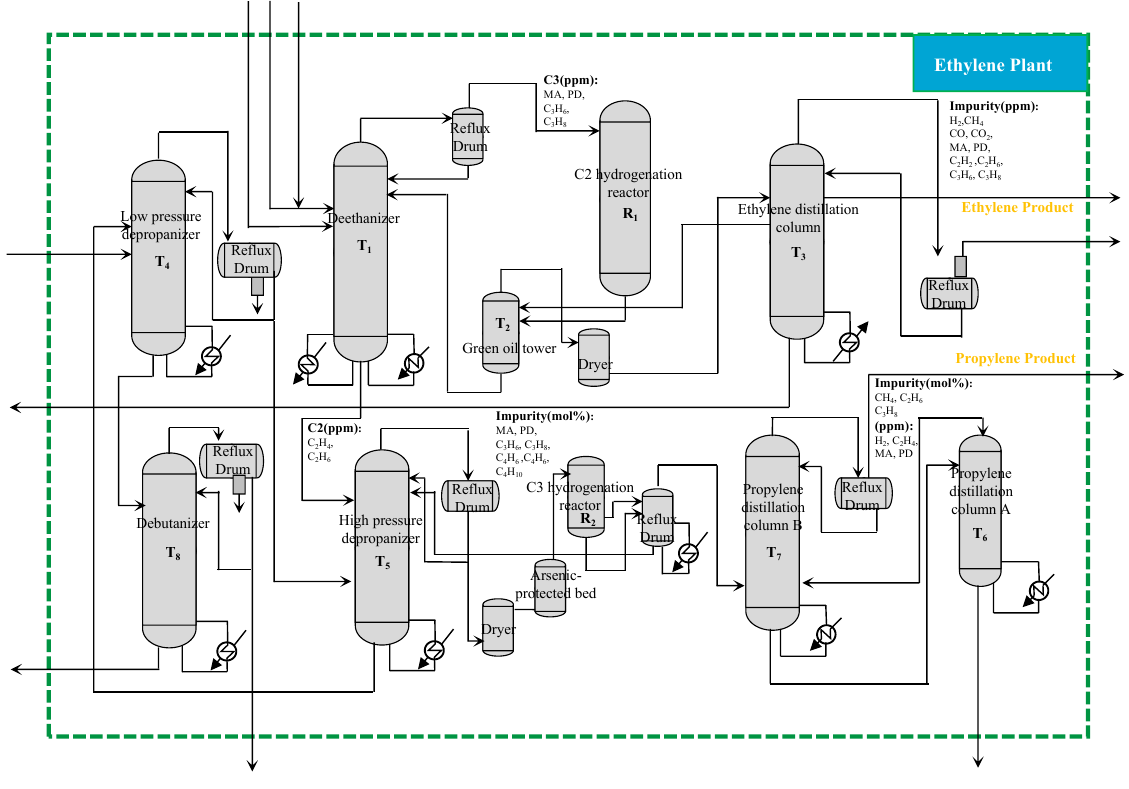
Figure 1. Diagrammatic sketch of an ethylene